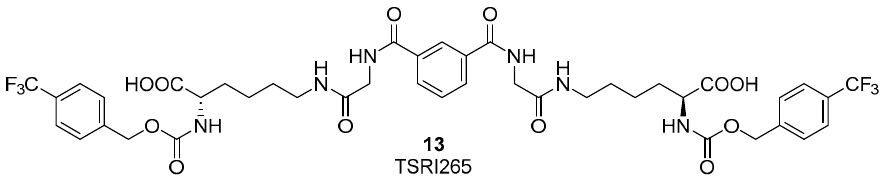
Figure 6. Chemical structure of TSRI265, an α v β 3 ligand able to disrupt the integrin-MMP2 interaction and showing antiangiogenic activity.